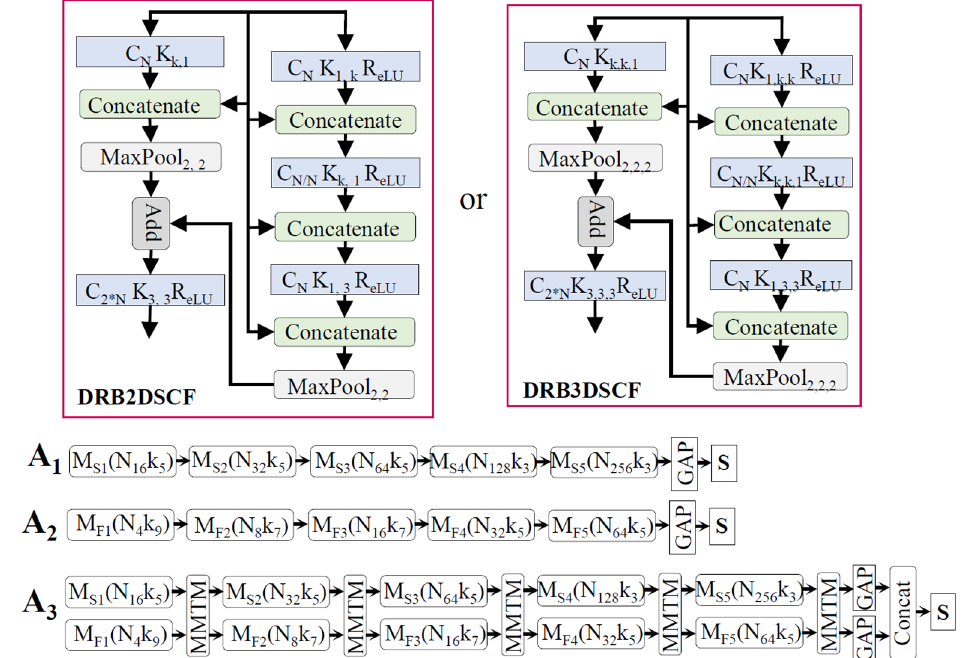
Figure 4. The block diagram of the proposed music video emotion classification network using slow (A 1 ), fast (A 2 ), or slow–fast network with MMTM (A 3 ) and with the separable channel and filter convolution. The acronyms DRB2DSCFC and DRB3DSCFC are the detailed views of the dense residual block with 2D and 3D separable channel and filter convolution for the music and video/face networks. The symbols have the same meanings as the symbols in Figure 3.